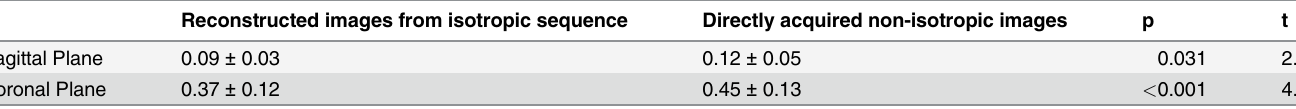
Table 6. Relative tumor contrast between tumor to fat. Reconstructed images from isotropic sequence Directly acquired non-isotropic